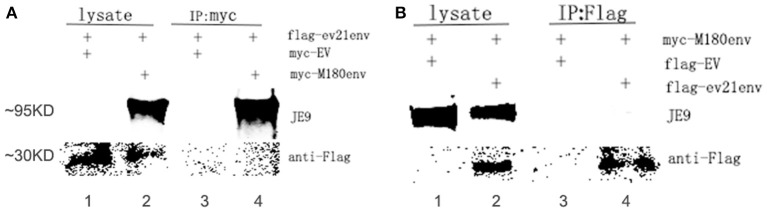
Analysis of the interaction between M180 strain envelope protein and the ev21 envelop protein. (A) Co-IP of the M180 envelope protein and the ev21 envelope protein using anti-myc. Co-IP with anti-myc in DF-1 cells co-transfected with pmyc-M180env and pflg-ev21env (lane 2, 4), or with pCMV-myc empty vector (EV) and pflg-ev21env (lane 1, 3). At 24 h post-transfection, cells were lysed and evaluated with western blotting directly (lysate) or co-IP (IP: myc). M180 envelope protein band was separated by 10% SDS-PAGE and detected using ALV-J envelope protein specific monoclonal antibody JE9. The ev21 envelope protein band was separated by 15% SDS-PAGE and detected using mouse anti-Flag Mab. (B) Co-IP of M180 envelope protein and ev21 envelope protein using anti-Flag. DF-1 cells co-transfected with pflg-ev21env and pmyc-M180env (lane 2, 4), or pCMV-flg empty vector (EV) and pmyc-M180env (lane 1, 3).